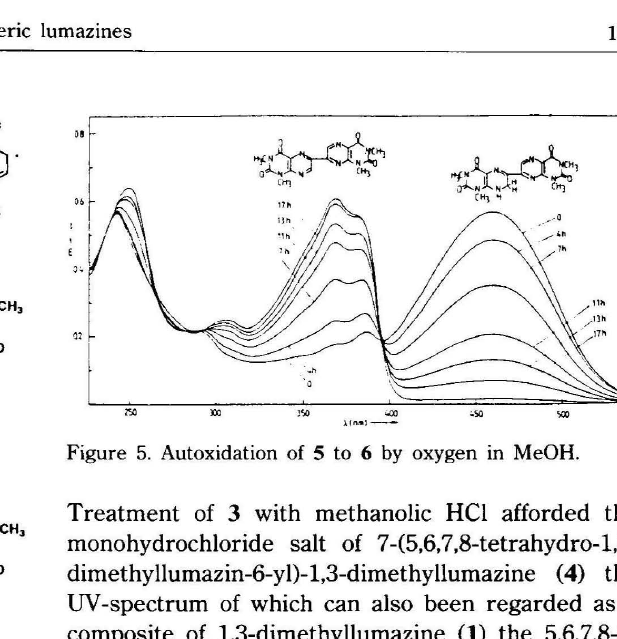
Figure 5. Autoxidation of 5 to 6 by oxygen in